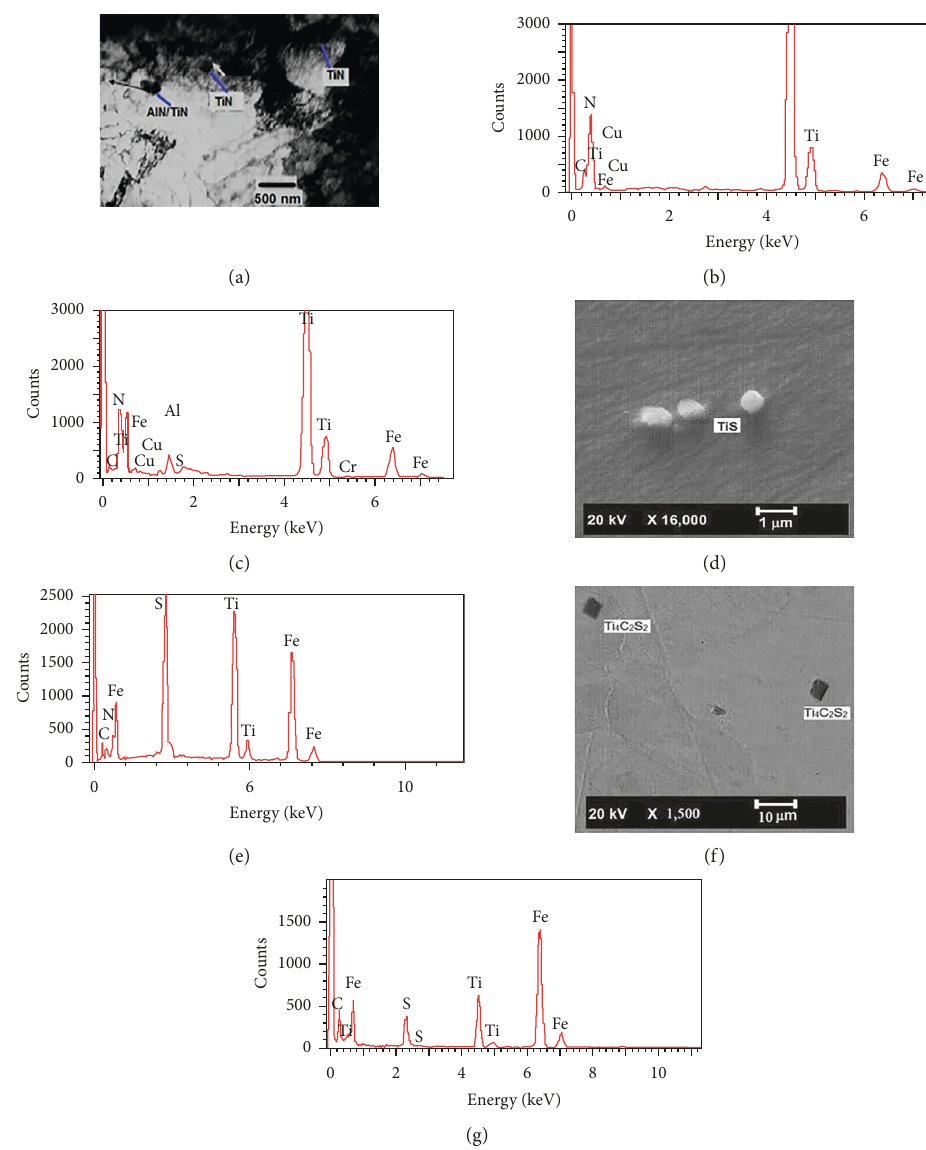
Figure 3: (a) Transmission electron micrographs (TEMs) showing precipitates with rhombohedral morphology (TiN), (b, c) EDX spectra of precipitates displayed, (d) SEM of TiS precipitates, (e) EDX spectra of TiS precipitates, (f) SEM of Ti 4 C 2 S 2 precipitates, and (g) EDX spectra corresponding to Ti 4 C 2 S 2